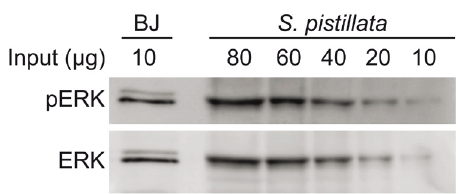
Supplementary Figure S1. Uncropped blot images for Figure 2 and supplementary replicates. ( A ) Biological replicates of fluorescent immunoblots performed in control conditions (Ct) are shown (Replicates 1 and 2). The portions of the images used in the main text are outlined. ( B ) Biological replicates of